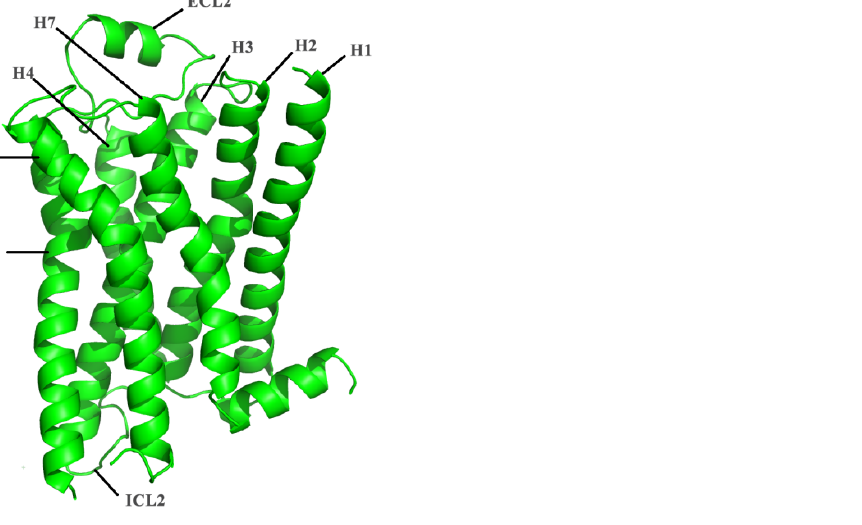
Figure 1. The crystal structure of β 2 AR (PDB ID: 2RH1) and the seven transmembrane helices H1–H7, as well as the ECL2 and ICL2 loops.